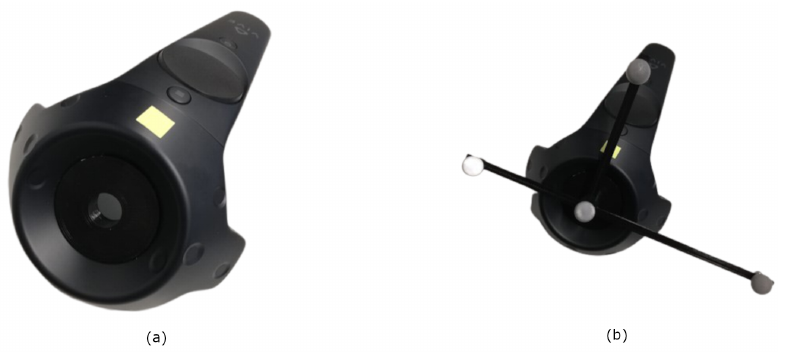
Figure 6. HTC Vive controller: ( a ) Calibration setup. ( b ) Tracking setup.